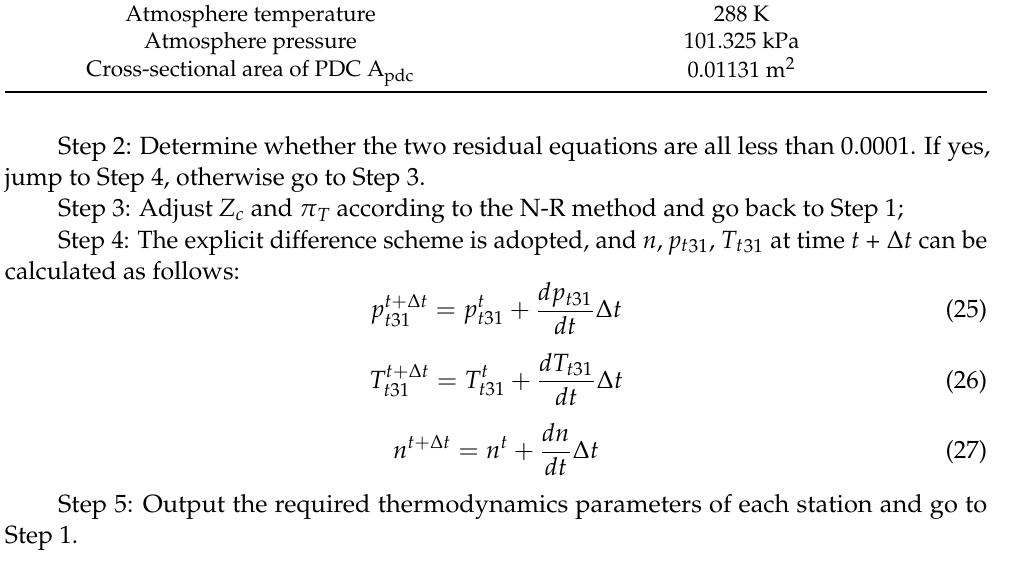
Table 1. On-ground parameters used in the calculation. Conditions Value Flight altitude H 0 km Mach number Ma 0 Atmosphere temperature 288 K Atmosphere pressure 101.325 kPa Cross-sectional area of PDC A pdc 0.01131 m